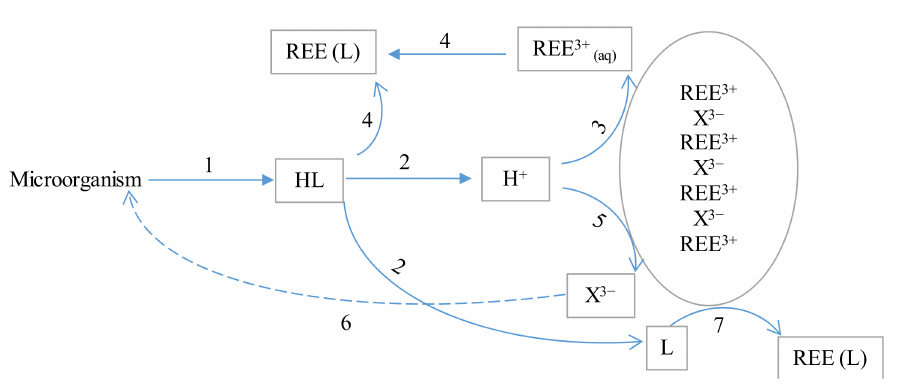
Figure 4. Possible mechanisms and reactions of REE bioleaching where (1) ligand (L) is secreted, (2) ligand dissociates, (3) proton promoted dissolution due to reaction with REE 3+ , (4) reaction of REE 3+ (aq) with ligand protonated (HL), (5) dissolution of proton promoted due to reaction with arbitrary anion (X 3 − ), (6) X 3 − up taking by microorganism, and (7) dissolution of ligand promoted. Adapted from